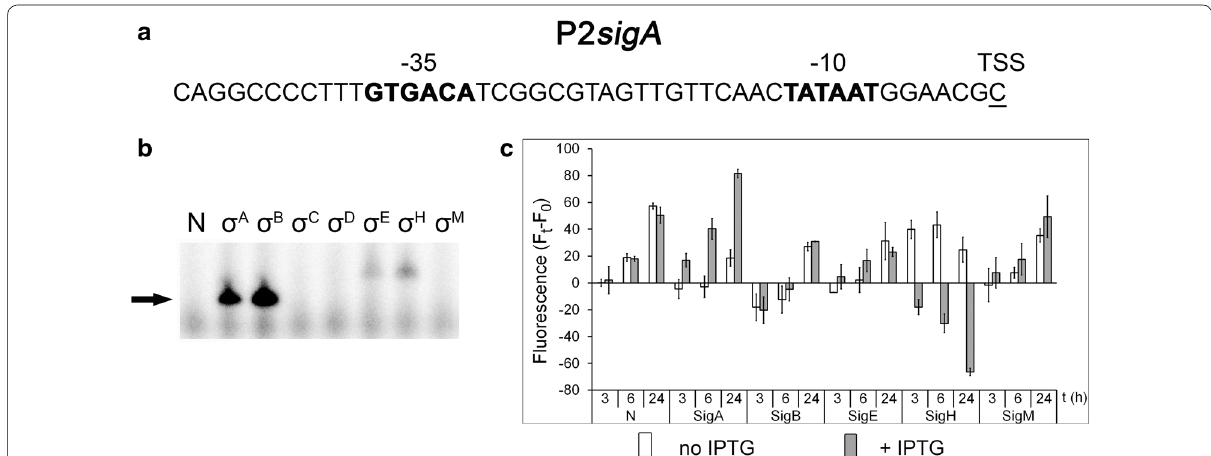
Fig. 6 Assignment of sigma factors to the P2 sigA promoter. a Sequence of the P2 sigA promoter (Halgasova et al. 2001). b In vitro transcription with P2 sigA as a template. Individual sigma factors associated with RNAP are shown at the top . The specific transcripts are indicated with an arrow . c P2 sigA promoter activity determined with the two-plasmid system in C. glutamicum WT by measuring the fluorescence intensity of the Gfpuv reporter. F t F 0 is the difference between the fluorescence at the sampling time (3, 6, 24 h) and the fluorescence at time 0 (before sigma gene − induction). The sigma factors whose genes were overexpressed are indicated at the bottom . The SDs of three measurements are depicted as error